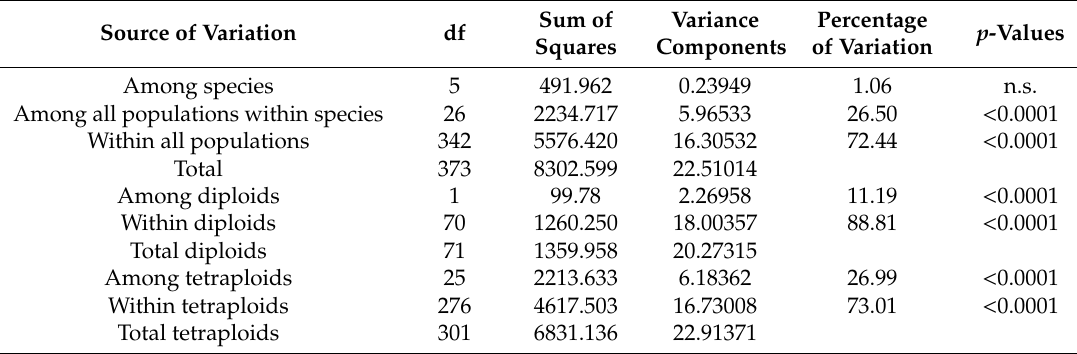
Table 1. Partitioning of genetic variance. AMOVA was performed at three hierarchical levels to test the di ff erentiation between 374 individual samples from 32 populations and six species. The table shows: degrees of freedom (df), sum of squared deviations, variance component estimates, percentages of total variance contributed by each component, and the probability of obtaining a more extreme component estimate by chance alone (p). p -Values were estimated with 1023